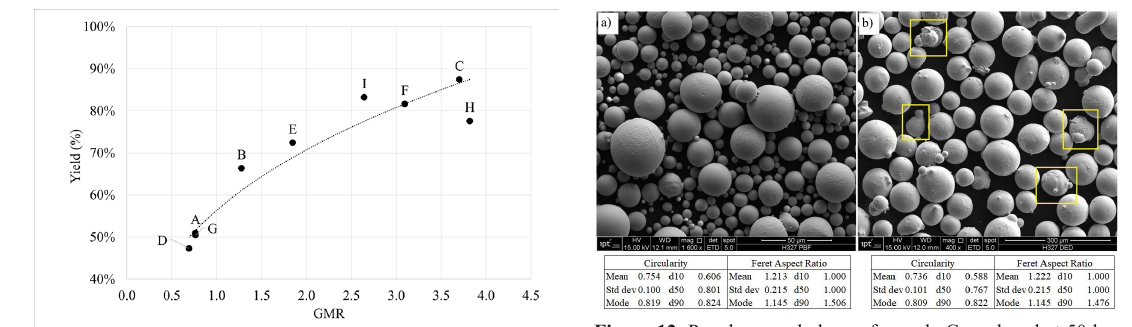
Figure 12. Powder morphology of sample C produced at 50 bar of gas pressure and 1.5 mm of tip diameter of a) PBF (10-45 μm) and b) DED (45-105 μm)